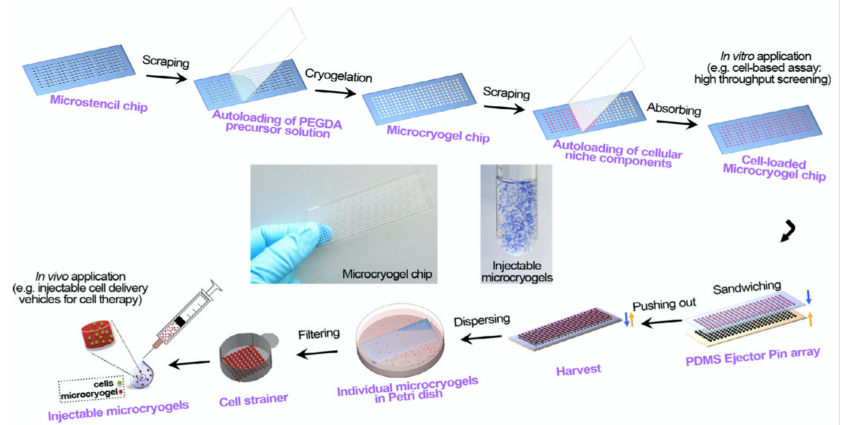
Figure 4. Schematic description of the preparation steps of injectable PEGDA-based microcryogels with microstencil array chips (Sandwiching step: Microcryogels are harvested by a simple push-out method using a poly(dimethylsiloxane) (PDMS) ejector pin array.)